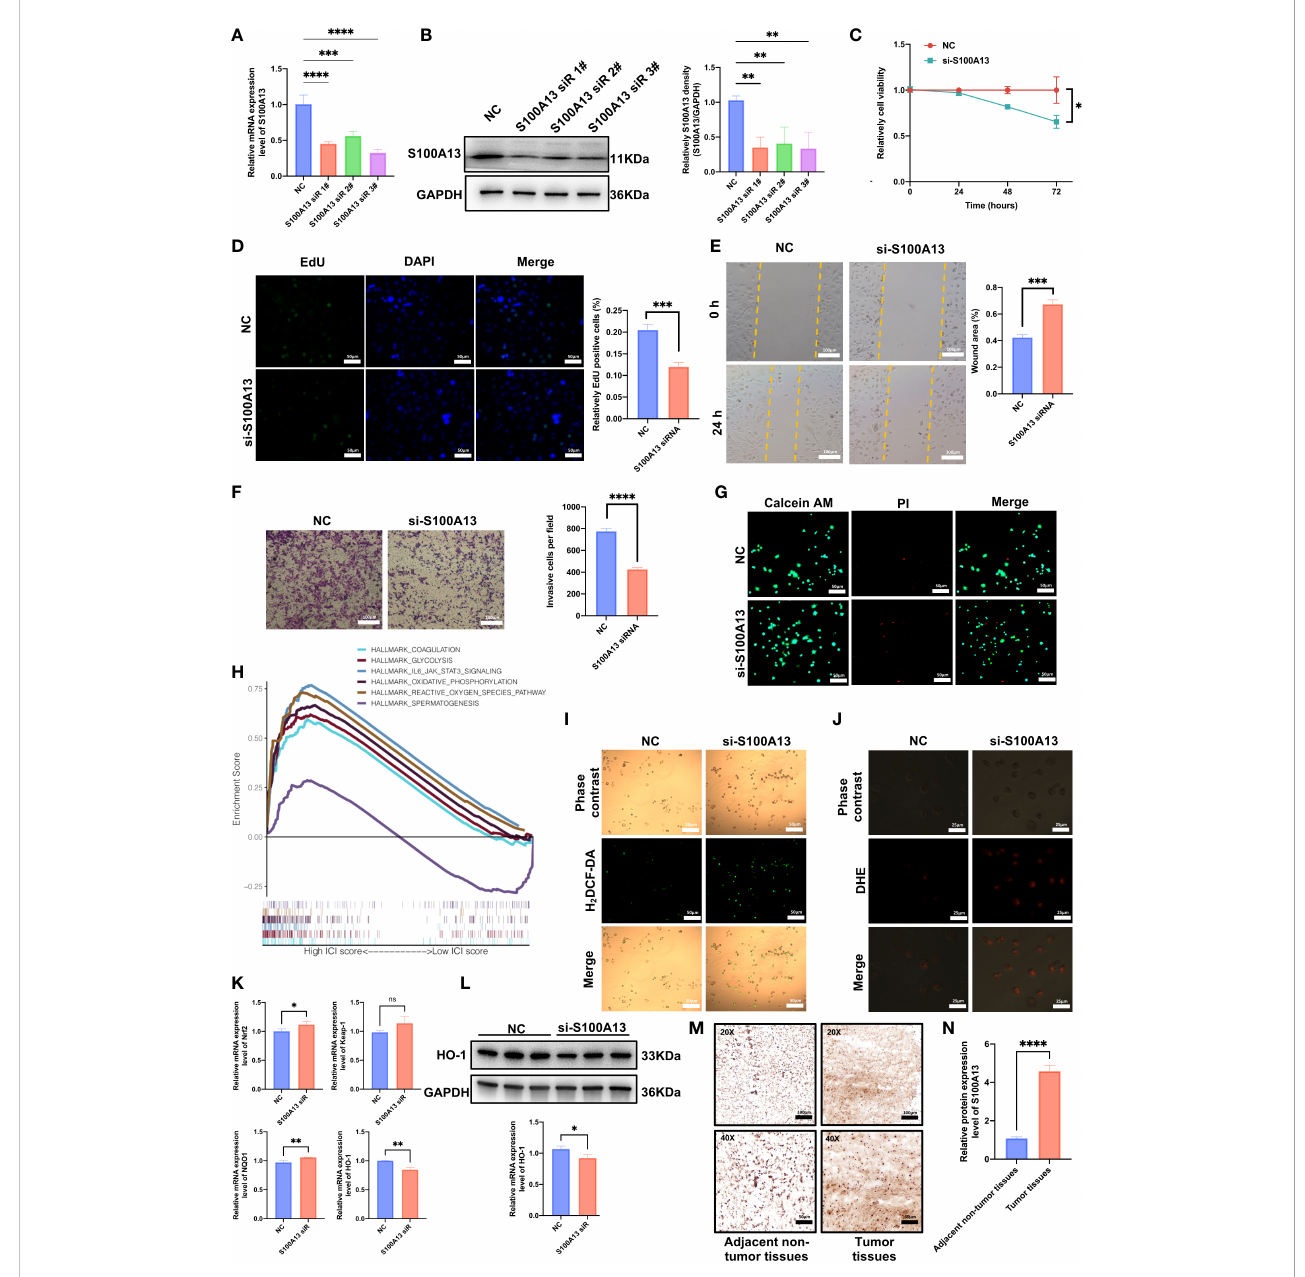
FIGURE 8 S100A13 inhibits the proliferation and migration capacity of UVM cells by disturbing the level of oxidative stress. (A) The qRT-PCR assays validated the siRNA knockdown effect. (B) Western blot experiment validated the siRNA knockdown effect with statistical analysis. (C) The results of CCK-8 assay. (D) EdU assay of UVM cell lines treated with siRNA or negative control (NC) of S100A13. (E) Scratch wound healing assay of UVM cell lines treated with siRNA or NC of S100A13. (F) Transwell assay of UVM cell lines treated with siRNA or NC of S100A13. (G) The live/dead staining assay of UVM cell lines treated with siRNA or NC of S100A13. (H) According to the GSEA results, there is a signi fi cant positive correlation between S100A13 expression and the ROS pathway. (I) H 2 DCF-DA staining of UVM cell lines treated with siRNA or NC of S100A13. (J) DHE staining of UVM cell lines treated with siRNA or NC of S100A13. (K) The mRNA expression of ROS-related gens in UVM cell lines treated with siRNA or NC of S100A13. (L) Western blot experiment validated the protein level of HO-1 based on siRNA knockdown effect with statistical analysis. (M) Illustrations of S100A13 immunohistochemistry (IHC) staining in tumor tissues and adjacent non-tumor tissues. (N) Relative expression of the S100A13 in tumor tissues and adjacent non-tumor tissues. * p < 0.05, ** p < 0.01, *** p < 0.001, **** p < 0.0001; ns, no signi fi